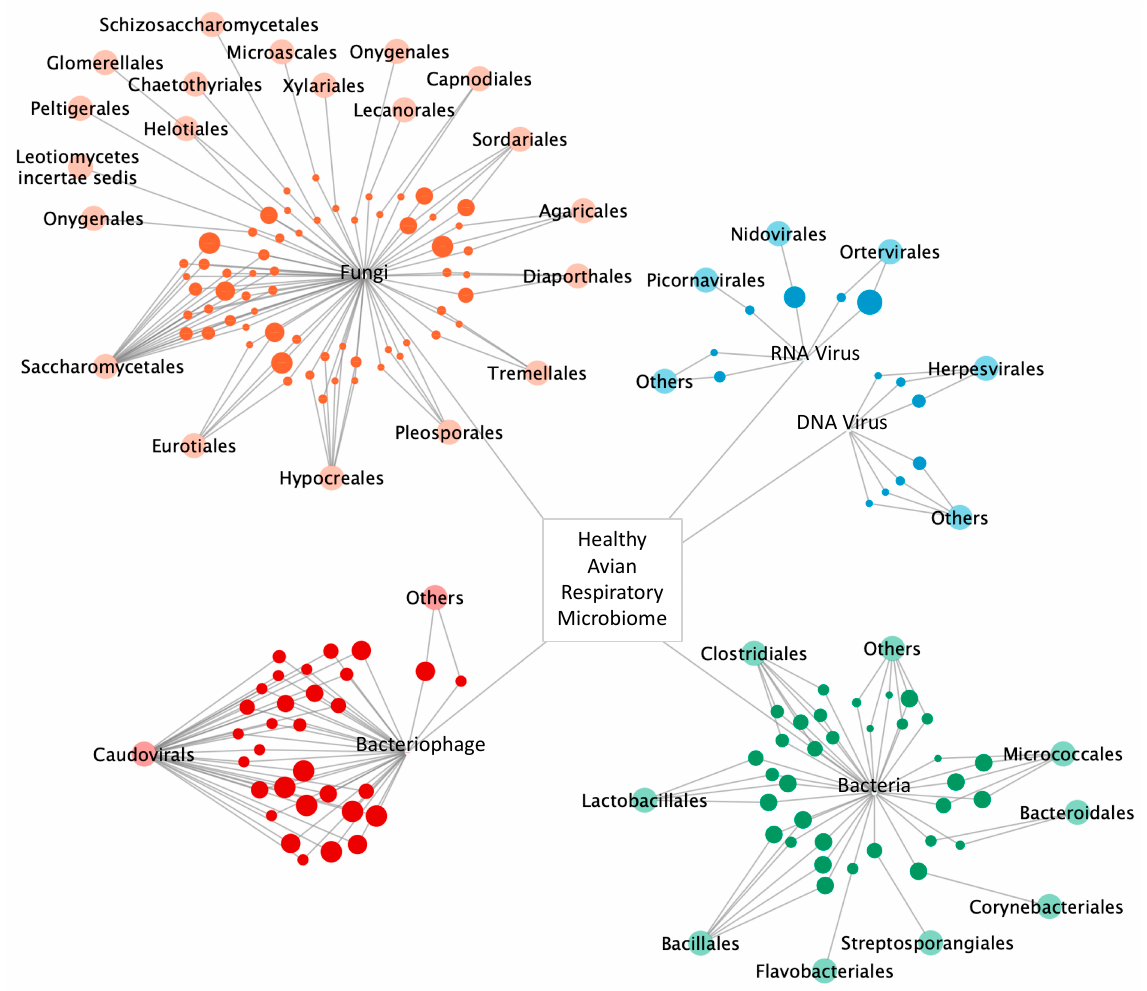
Figure 6. Microbial network of the complete healthy avian respiratory microbiome including detected RNA viruses, DNA viruses, yeast and fungi, bacteria, and bacteriophage. Taxa nodes are arranged by order. Node diameter correlates to taxa frequency.